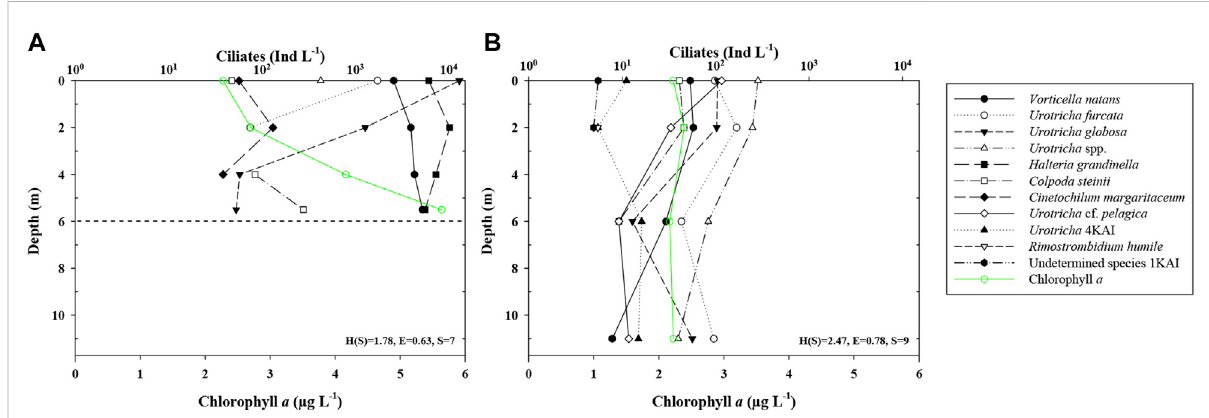
FIGURE 2 Verticaldistributionofciliates(meanabundance)andChl a inKaisersee(KAI).Thedottedhorizontallinemarksthemaximum fi llingonthedayof sampling. (A) summer sampling (August), (B) autumn sampling